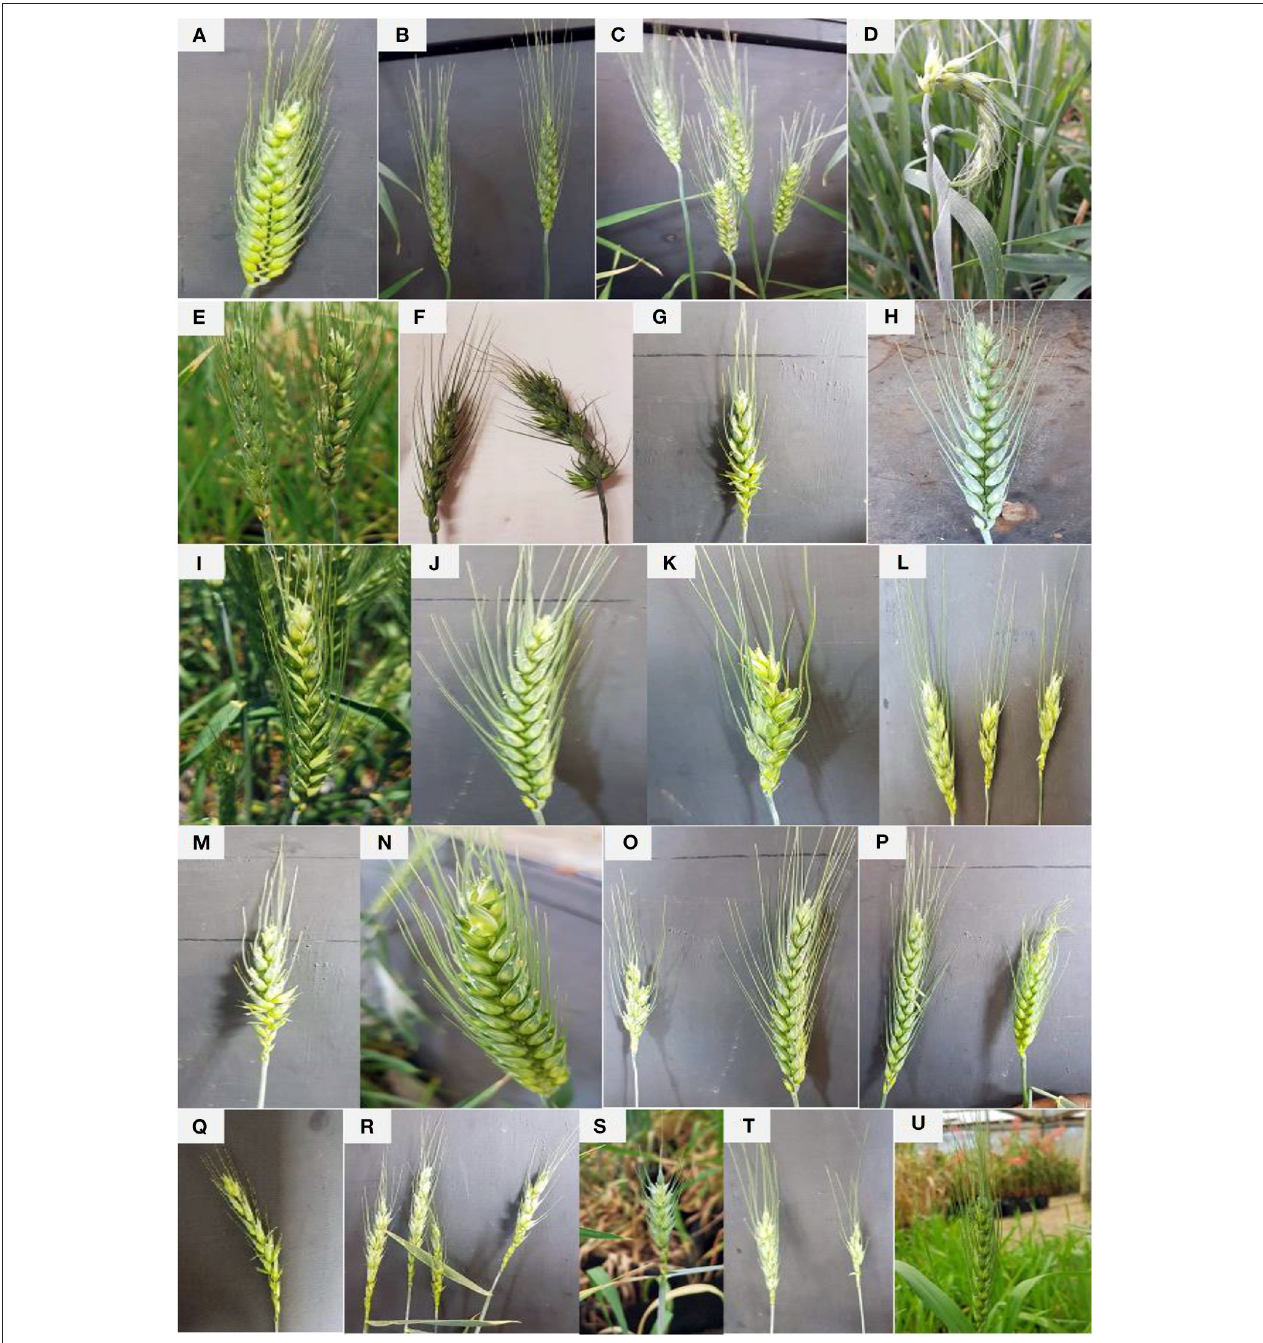
FIGURE 6 | (A–T) show variations in spike and awn morphology in wheat mutant populations during the M 3 generation under the controlled environment facility. (A–E) (Population 1), (F–M) (Population 2), (N–T) (Population 3) and (U) (Control).